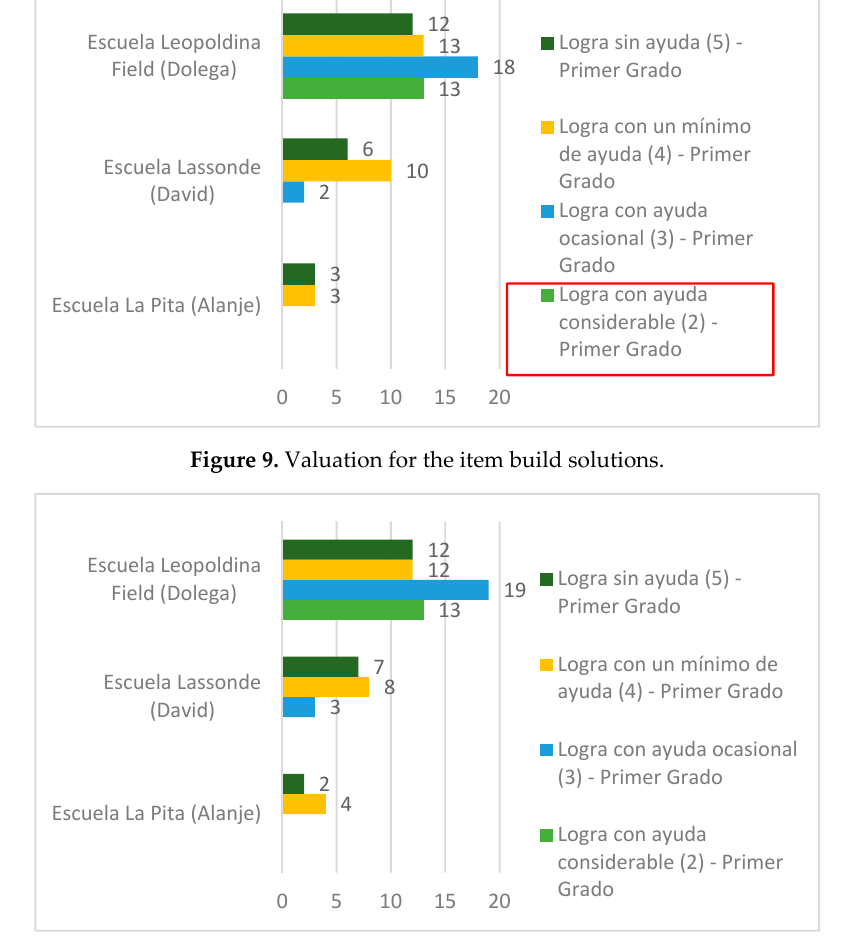
Figure 10. Valuation for the item robotics resources, programming sequence and learning by inquiry.